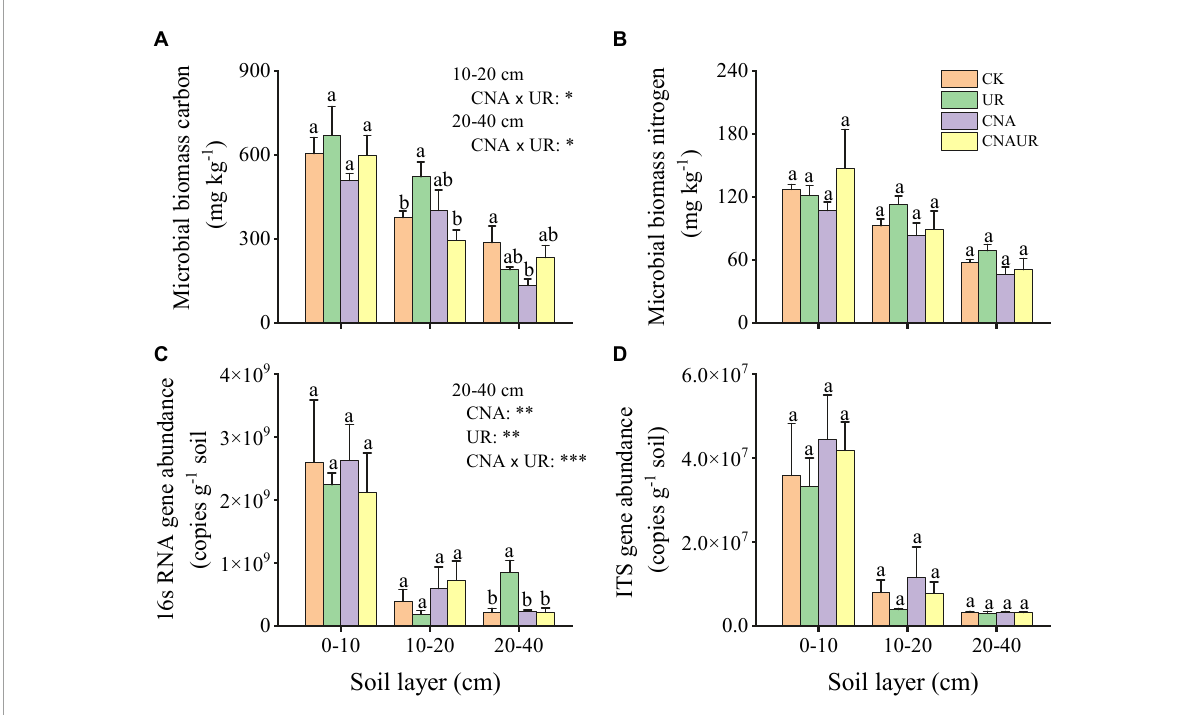
FIGURE1 Contents of microbial biomass C (A) and N (B) and gene abundances of bacteria (C) and fungi (D) in three soil layers as affected by four treatments, i.e., two levels ( ± ) of canopy N addition (CNA) and two levels ( ± ) of understory removal (UR), and the statistical interaction CNA × UR. Treatments are described in Table 1 . Values are means + SE. In each plot, means with different letters are significantly different at p < 0.05. ∗ , ∗∗ , and ∗∗∗ indicate significance at p < 0.05, 0.01, and 0.001, respectively.